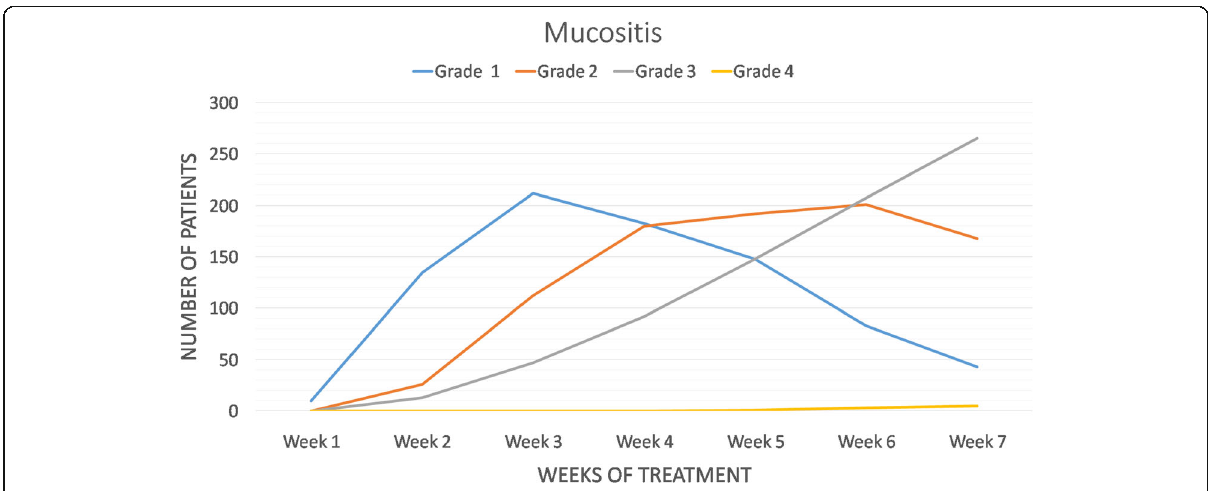
Fig 2 Temporal evolution of the pattern of mucositis per